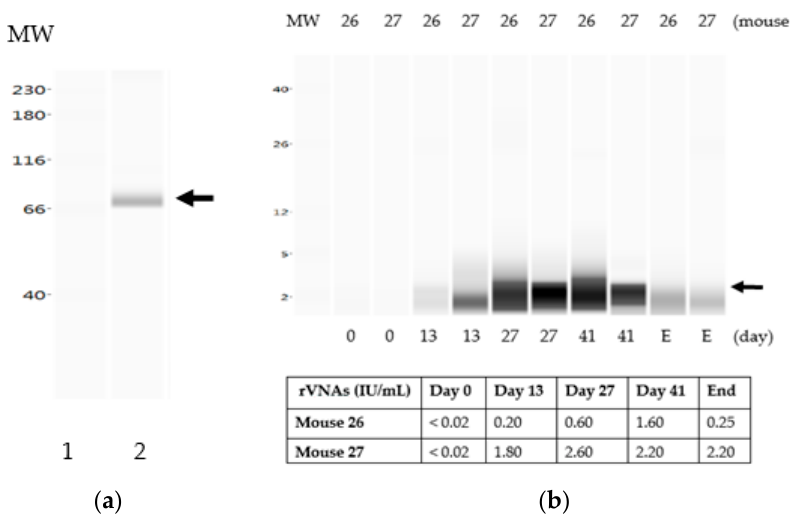
Figure 3. Antibody dynamics of GnRH in mice vaccinated with the liquid ERA-2GnRH vaccine. Protein detection using the ProteinSimple Wes. ( a ) Detection of recombinant protein G-2GnRH using antibodies against GonaCon; lane 1, molecular weight (MW) marker; lane 2, recombinant G-2GnRH protein from purified ERA-2GnRH virus; ( b ) GnRH antibodies in representative mice receiving the liquid ERA-2GnRH vaccine over time; GnRH antibodies were detected in mouse 26 and 27 (Group B) from day 13 through day 41 and then decreased until the end of the experiment (E, ~day 70). Similarly, the rVNA titer was positive on day 13, went up on days 27 and 41, and declined until E.